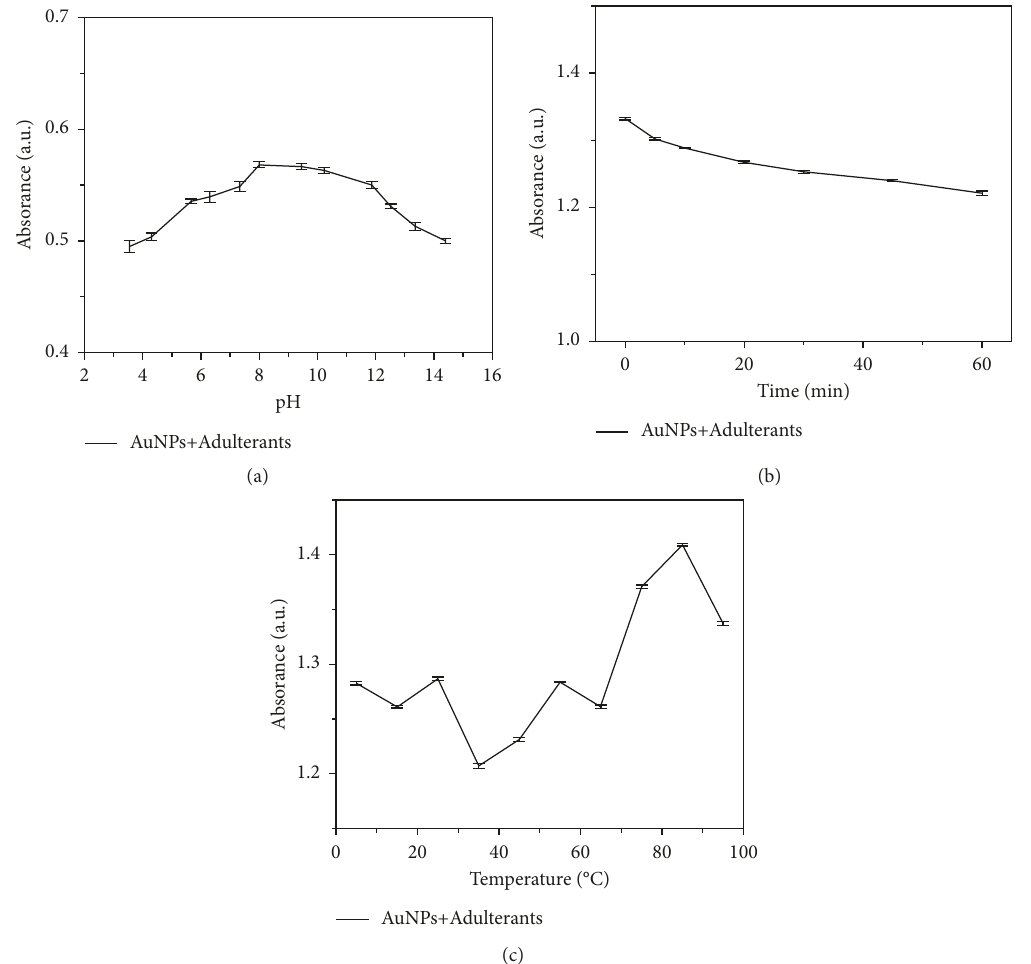
Figure 2: Condition optimization. (a) The pH value and absorbance of solution during reaction. (b) The reaction time and absorbance of solution during reaction. (c) The reaction temperature and absorbance of solution during